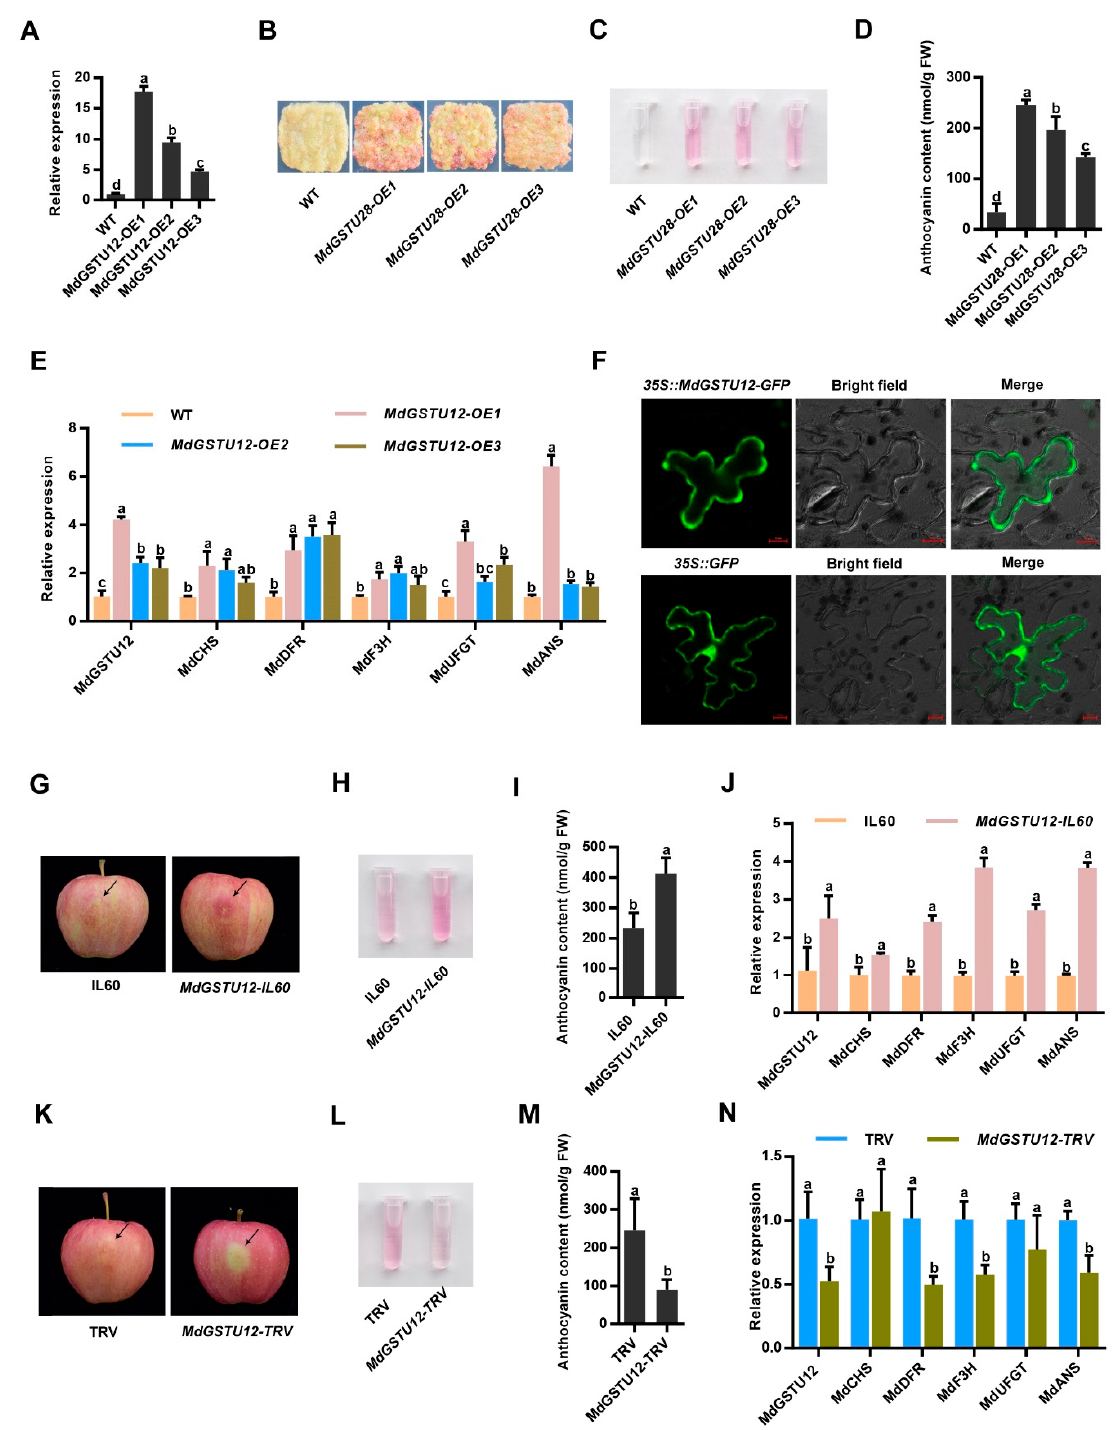
Figure 4. MdGSTU12 is involved in the regulation of anthocyanin accumulation and subcellular localization of MdGSTU12 protein. ( A ) The expression of MdGSTU12 in the wild-type (WT) and MdGSTU12 transgenic apple calli by RT-qPCR assay. ( B , C ) Calli coloration of two-week-old WT, MdGSTU12-OE1 , MdGSTU12-OE2 , and MdGSTU12-OE3 transgenic calli. ( D ) Anthocyanin contents in the apple calli are shown in ( B ). ( E ) Expression analysis of MdGSTU12 and the anthocyanin biosynthesis-related genes MdCHS , MdDFR , MdF3H , MdUFGT , and MdANS by RT-qPCR assays in ( B ). ( F ) Subcellular localization of MdGSTU12 protein. 35S::GFP served as a control, scale bar = 10 µ m, BF represents a bright field. ( G ) Coloration of apple fruit peels injected with plasmid mixtures (IL60: IL60-1 + IL60-2; MdGSTU12-IL60 : IL60-1 + MdGSTU12-IL60-2 ). An empty IL60 vector was used as control. ( H , J ) Anthocyanin content ( H , I ) and relative expression levels of the anthocyanin